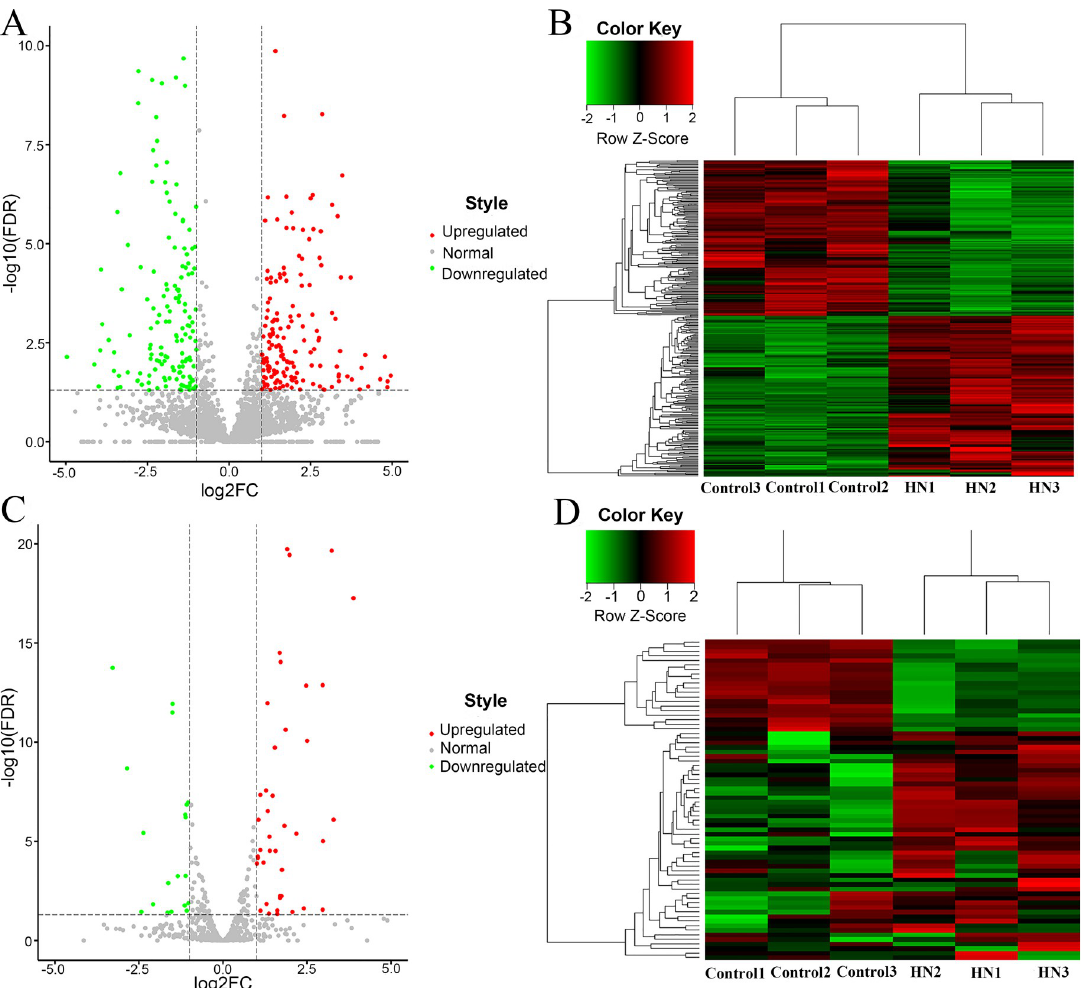
Fig 6. DE-lncRNAs and miRNAs in the renal HN rat model. (A) Volcano plot of DE-lncRNAs and miRNAs (C) between rats suffering from HN and normal control rats. Red nodes refer to lncRNAs that were upregulated [log2 (fold change) > 1, FDR < 0.05], while green nodes represent lncRNAs that were downregulated [log2 (fold change) < -1, FDR < 0.05]. Grey points indicate the lncRNAs and miRNAs expressed normally. (B) Hierarchical clustering of lncRNAs and miRNAs (D) shows the differential expression between the HN group and the control group. The closer to red, the higher the expression level. In contrast, green denotes downregulated expression profiles. LncRNA, long noncoding RNA; miRNA, microRNA; HN, hyperuricaemic nephropathy; FDR, false discovery